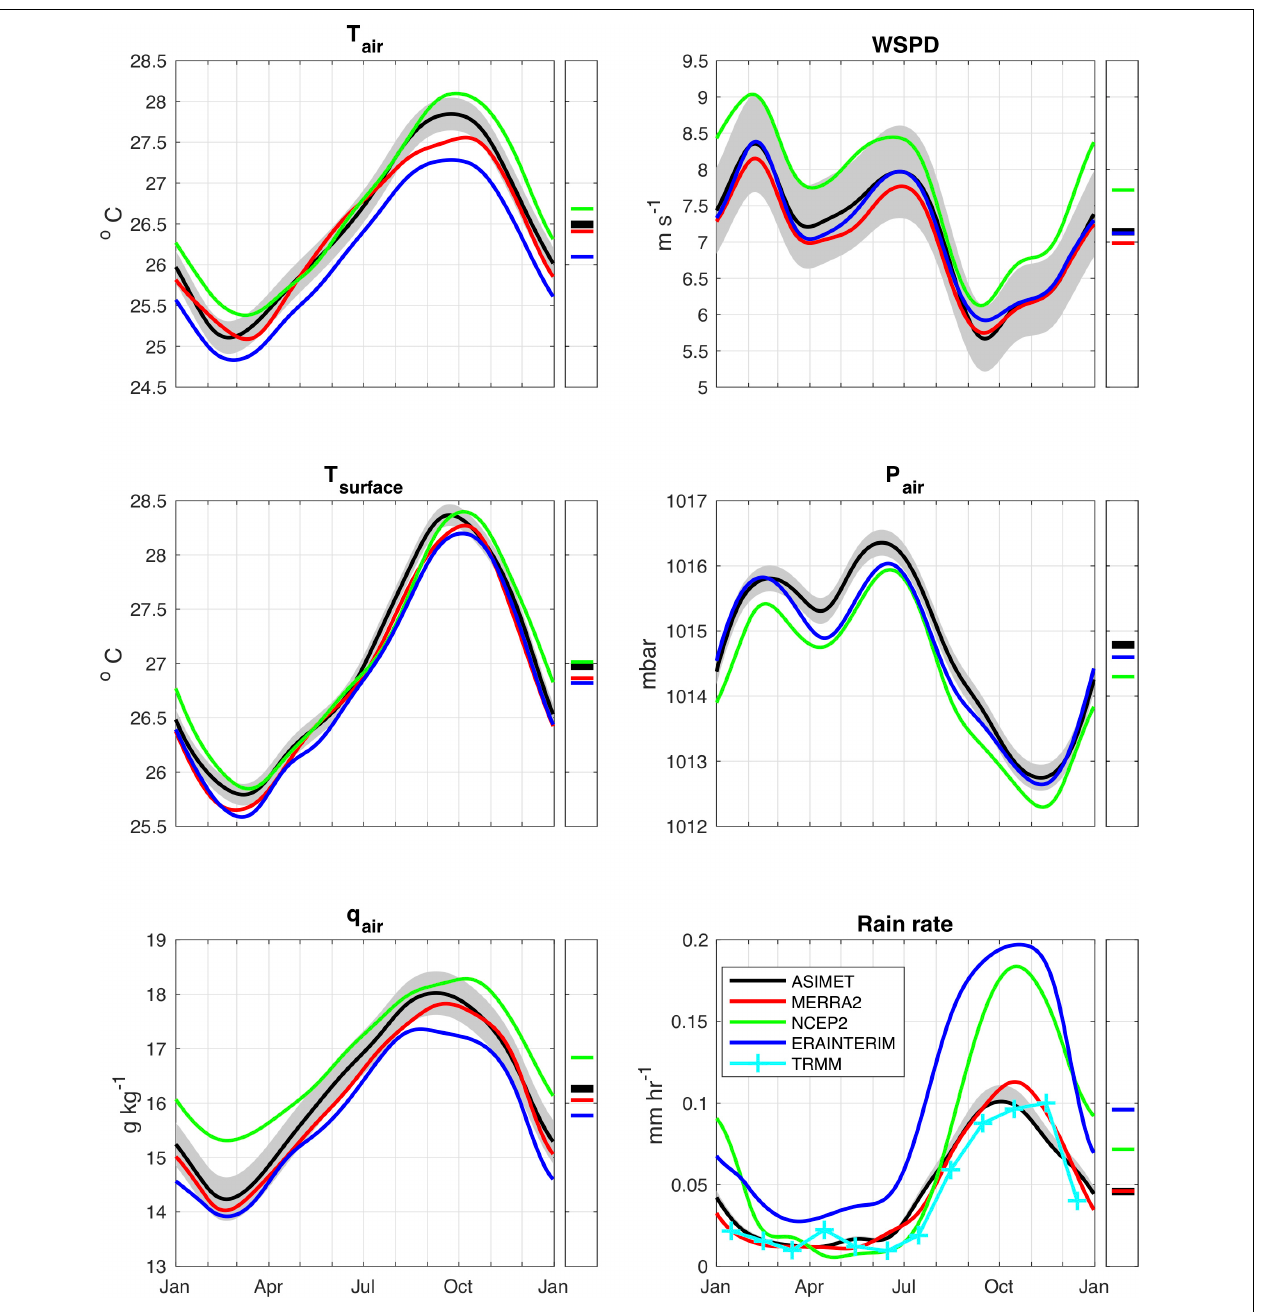
FIGURE 2 | Time-series of annual cycle of near surface meteorology at NTAS location, and annual averages on the right. From left to right, top to bottom: air temperature at 10 m, wind speed at 10 m, skin sea surface temperature, barometric pressure, specific humidity at 10 m, rain rate. Gray shading indicates error associated with ASIMET measurements on the NTAS buoy. ASIMET (black), MERRA-2 (red), NCEP-2 (green), ERA-Interim (blue). Based on daily data from April 1, 2001 through March 31,